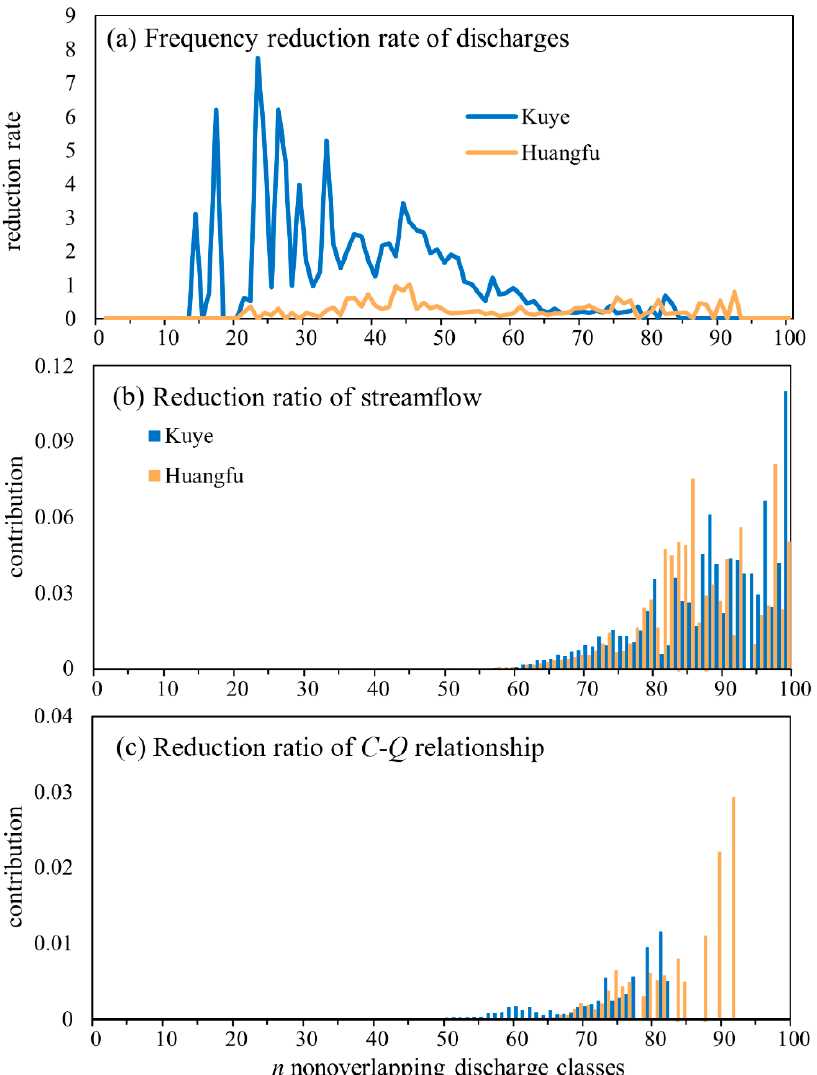
Figure 9. Comparison of ( a ) frequency reduction rate of discharges from baseline period to change period and contributions of ( b ) streamflow and ( c ) C-Q relationship reductions to suspended sediment yield (SSY) reductions in 100 discharge classes (the discharge was divided into 100 classes from low to high by an interval which is a hundredth of variation range of daily streamflows on the log-discharge scale, refer to the Methods Section for details) between the Huangfu and the Kuye basins.